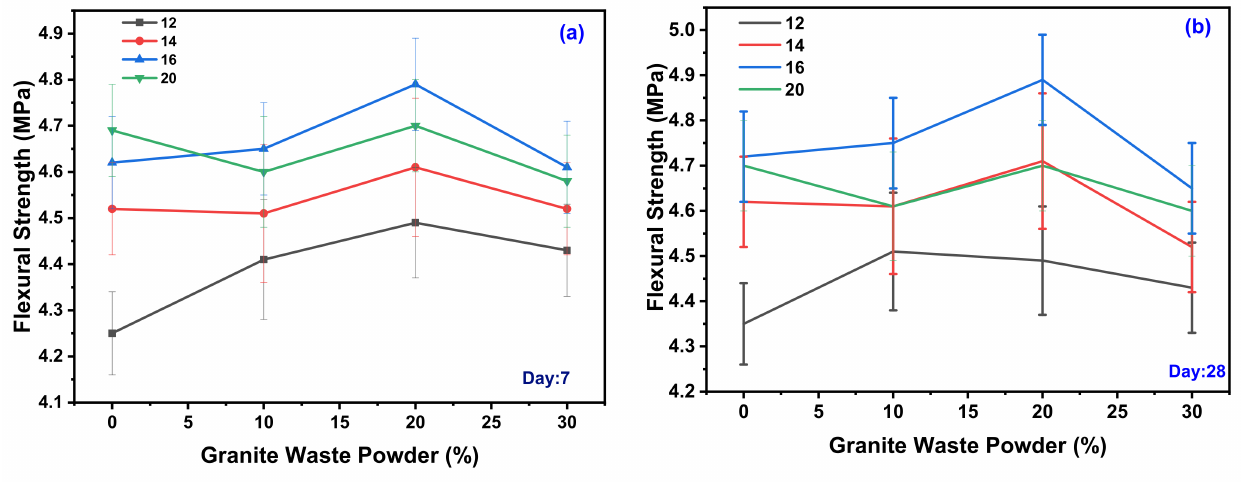
Figure 4. Variation of GWP on the different molarity for FS days 7 ( a ) and 28 ( b ). The FS observed during experimentation for various GPC-GS series, the range of FS observed was from 4.35 to 4.89 MPa for various design mixes for day 28 represented in Figure 4b. For 12 M of GPC, maximum FS was observed for GWP with 20% with 4.50 MPa and minimum FS observed for GWP with 0% with 4.35 MPa. For 14 M of GPC, maximum FS was observed for GWP with 20% with 4.71 MPa and minimum FS observed for